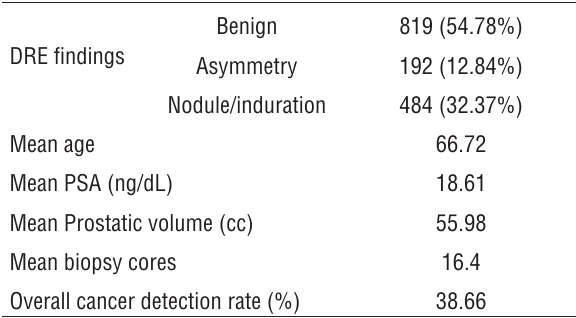
Table 1 - patients’